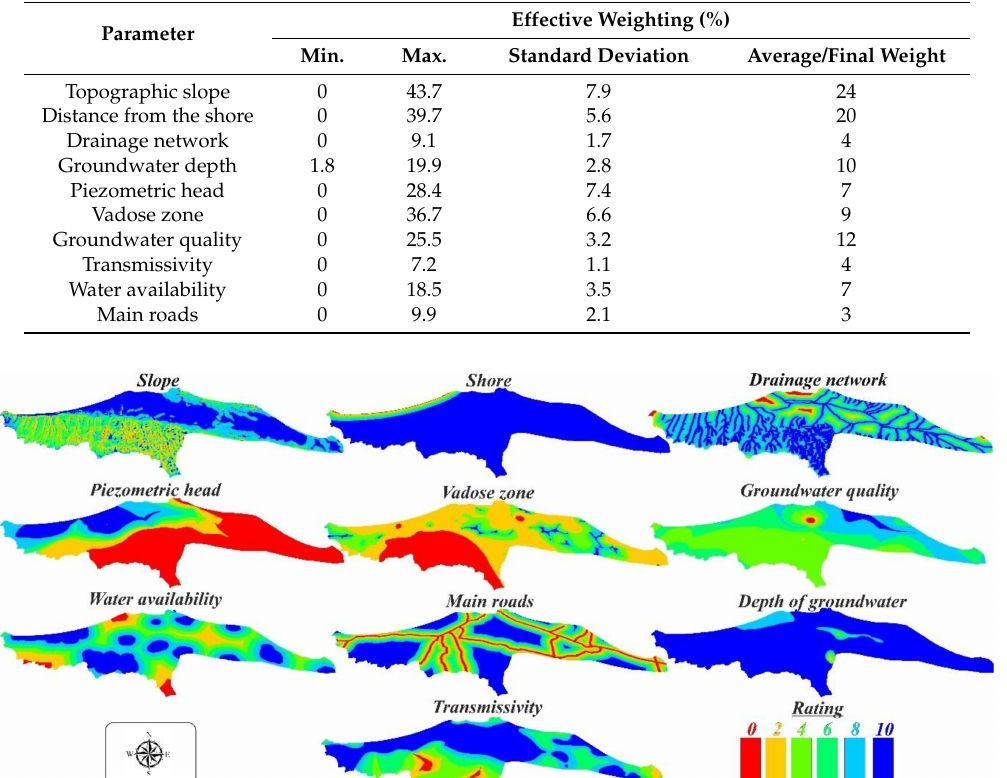
Table 4. Results of the sensitivity analysis.